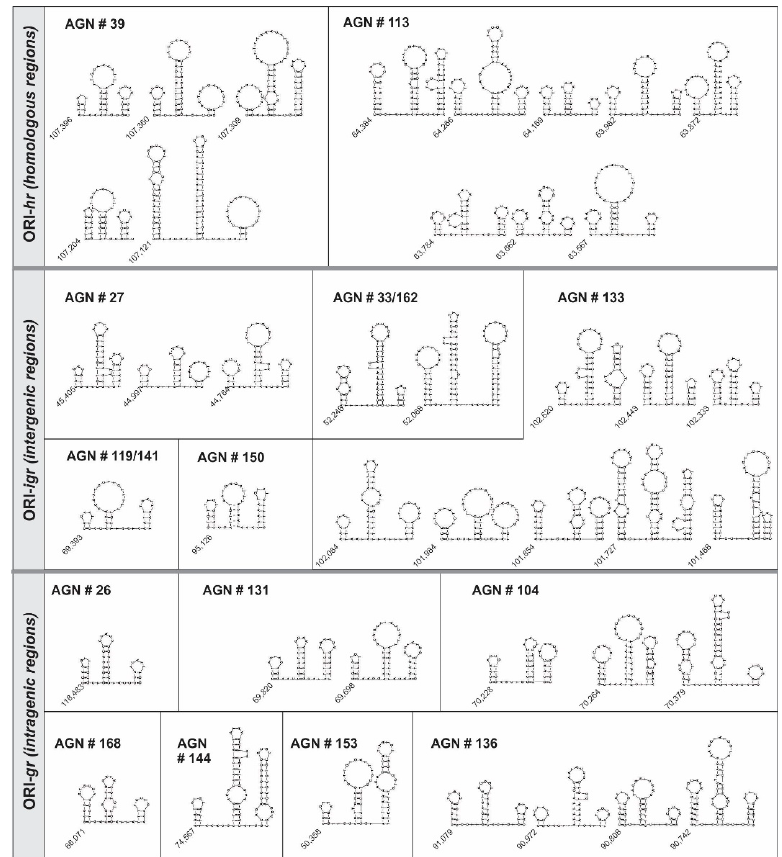
Figure 3. ORI sequences of AgMNPV and their putative structure. The illustration shows the putative secondary structures of the sequences recovered as ORI by the transient replication assay. ORIs are classified according their genome location and library clones are identified with their corresponding numbers. The nucleotide genome position of each sequence is indicated at the beginning of the DNA structure. Table 3. Putative DNA structures of AgMNPV ORIs.